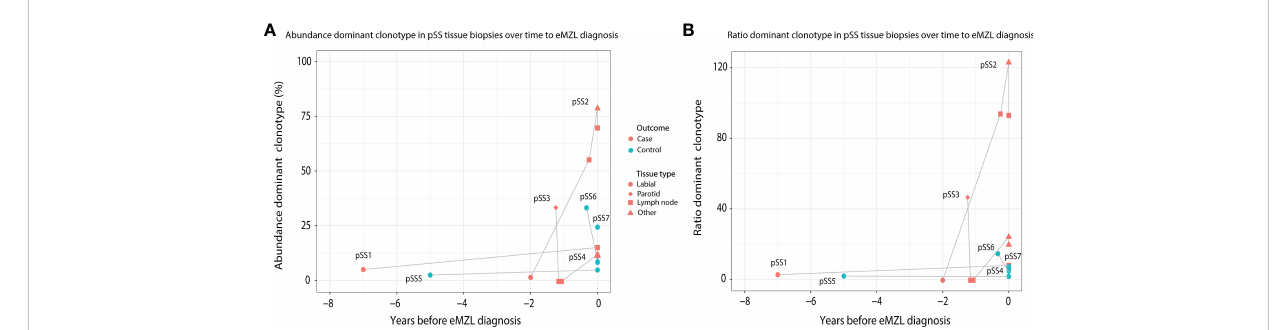
FIGURE 1 Abundance of eMZL clonotype in tissue biopsies obtained from pSS patients up to eMZL development. (A) The abundance of the dominant clone as a percentage of total reads in the IG gene repertoire (IGH for pSS1 and pSS2, IGK-Kde for pSS3, IGH for pSS4-7) is shown in various tissue samples of SS patients developing eMZL and pSS controls. (B) The ratio of the abundance of the dominant clonotype clonotype compared to the clonotypes ranked 3rd-7 th is depicted for both cases and controls. Tissue biopsies are further described in Supplementary Table